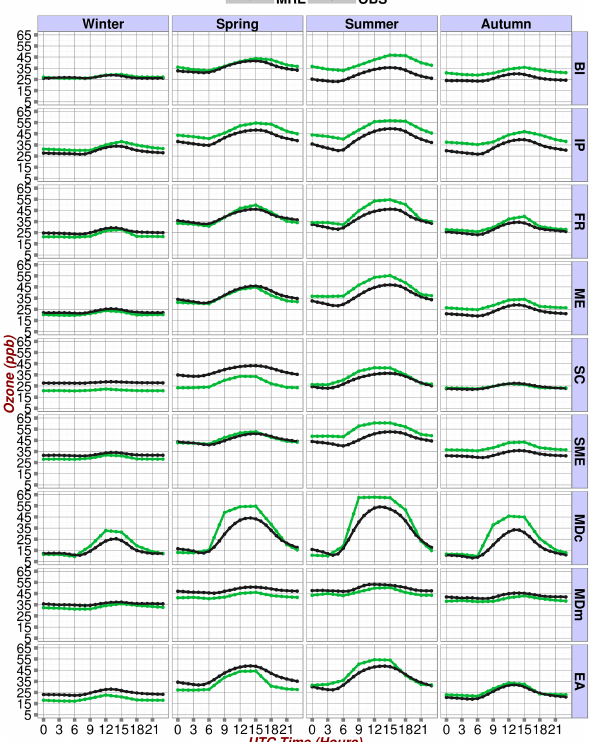
Figure 5. Mean 2003–2012 diurnal cycle of near-surface ozone for the different European subregions based on MRE (green line) and observations (black line) calculated for winter (DJF), spring (MAM), summer (JJA) and autumn